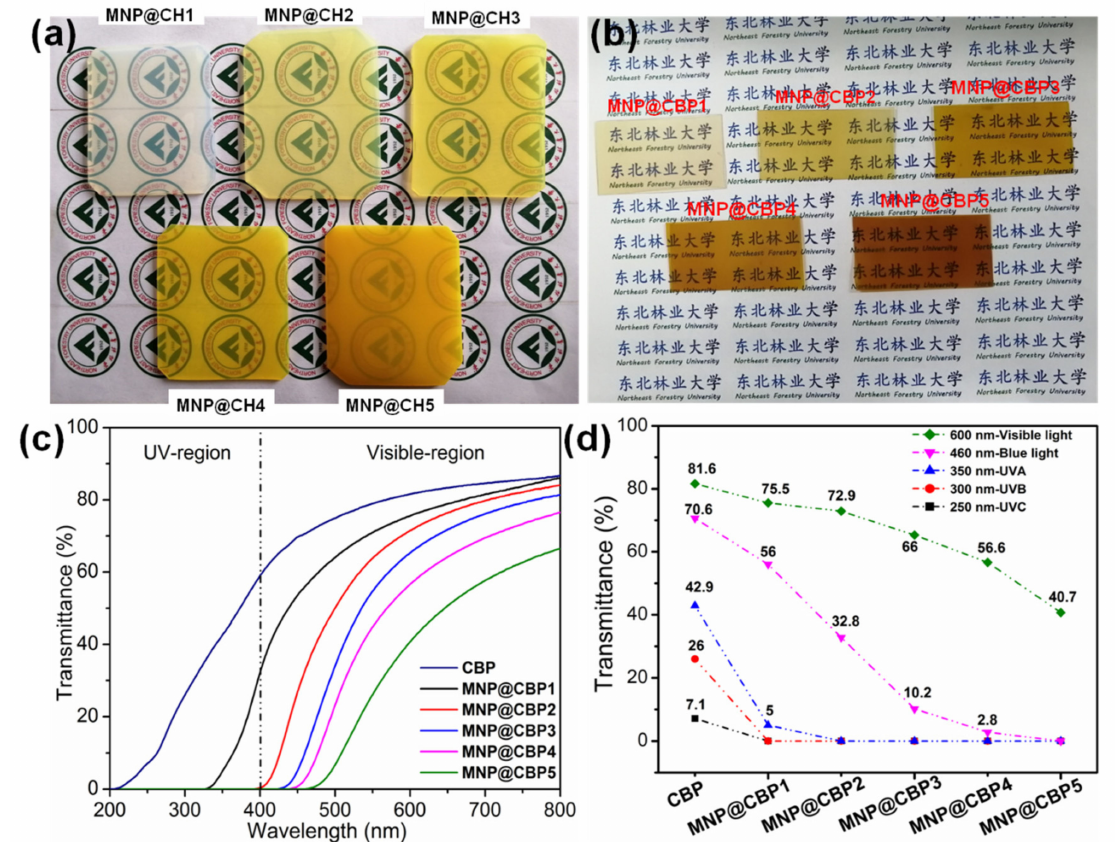
Figure 6. ( a ) Photographs of MNP@CHs, ( b ) photographs of MNP@CBPs, ( c ) UV-vis light transmittance curves of CBP and MNP@CBPs from 200 to 800 nm, ( d ) transmittance at specific UV light and blue light